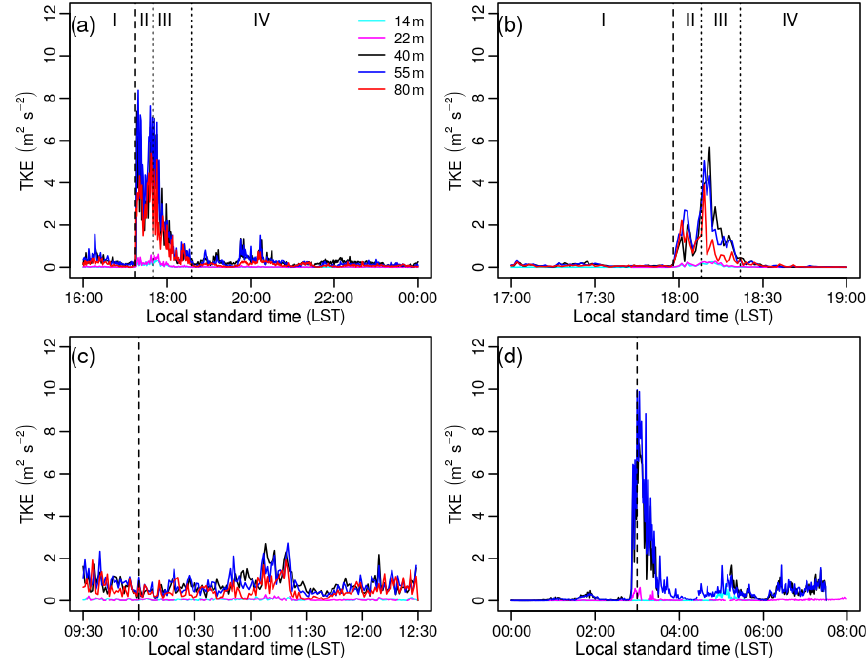
Figure 7. The same as in Fig. 2 but for turbulent kinetic